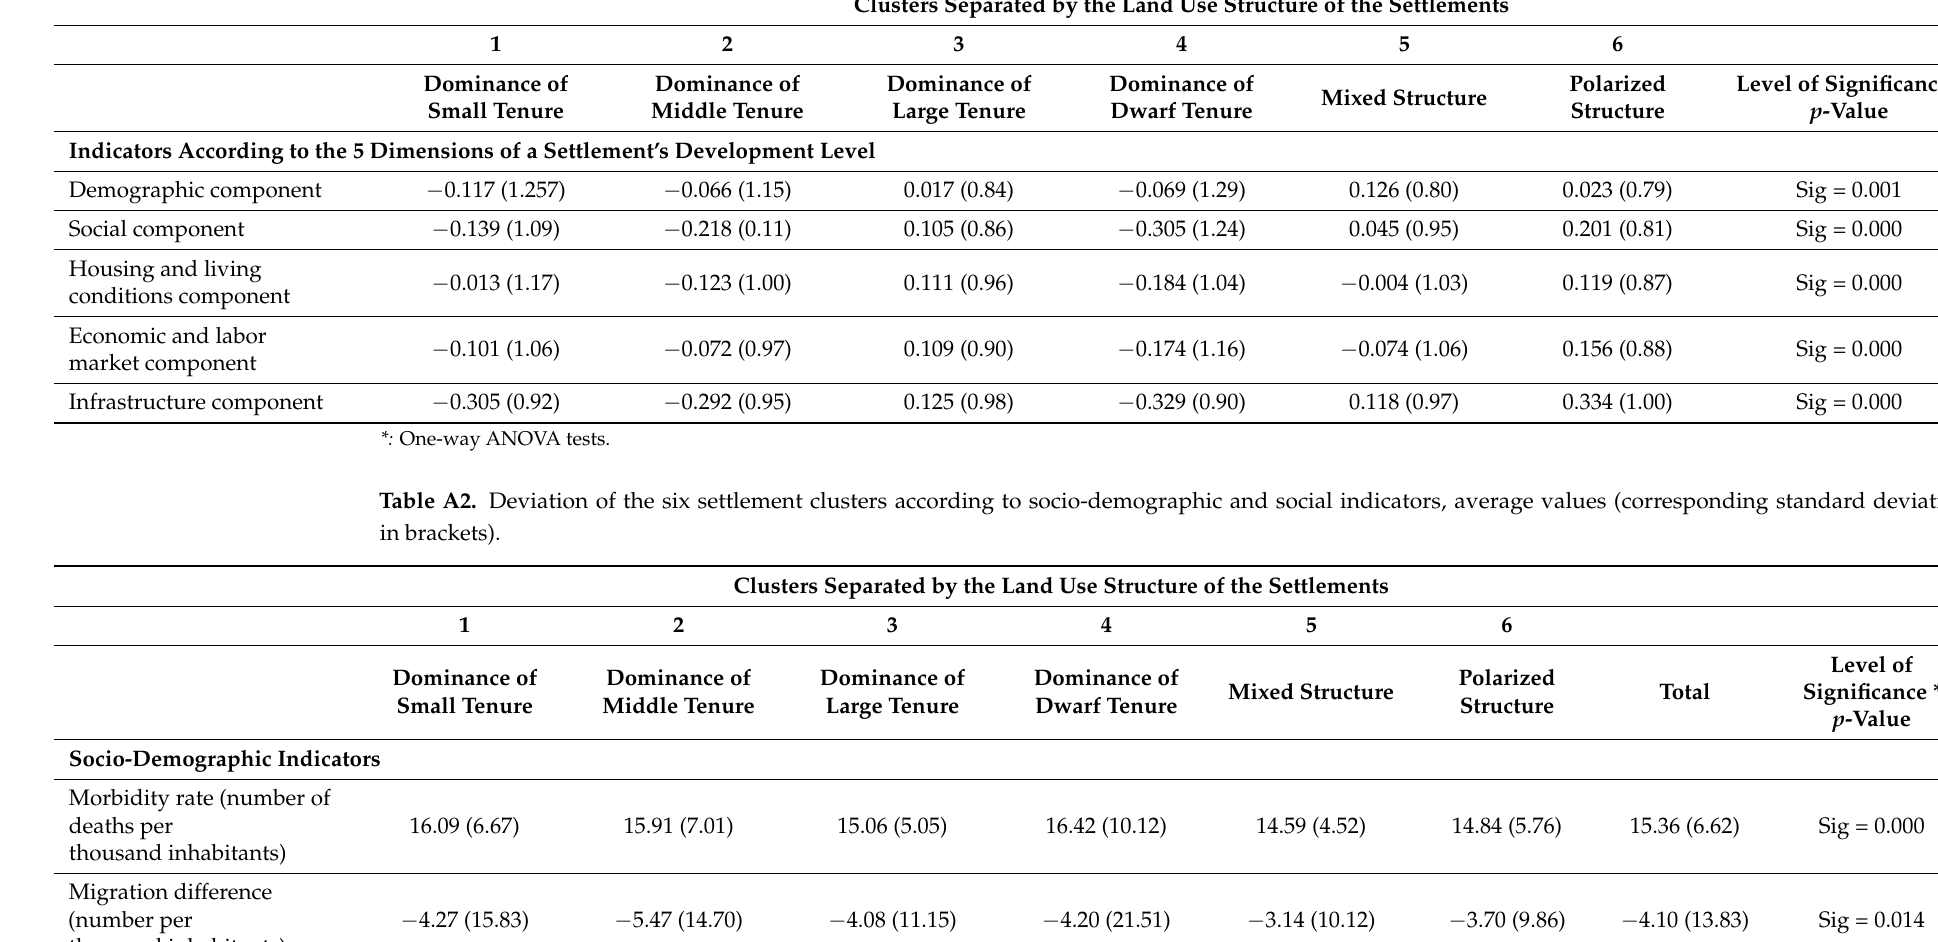
Table A1. Mean values of the six separate settlement clusters and settlement development components (standard deviations in brackets). Clusters Separated by the Land Use Structure of the Settlements